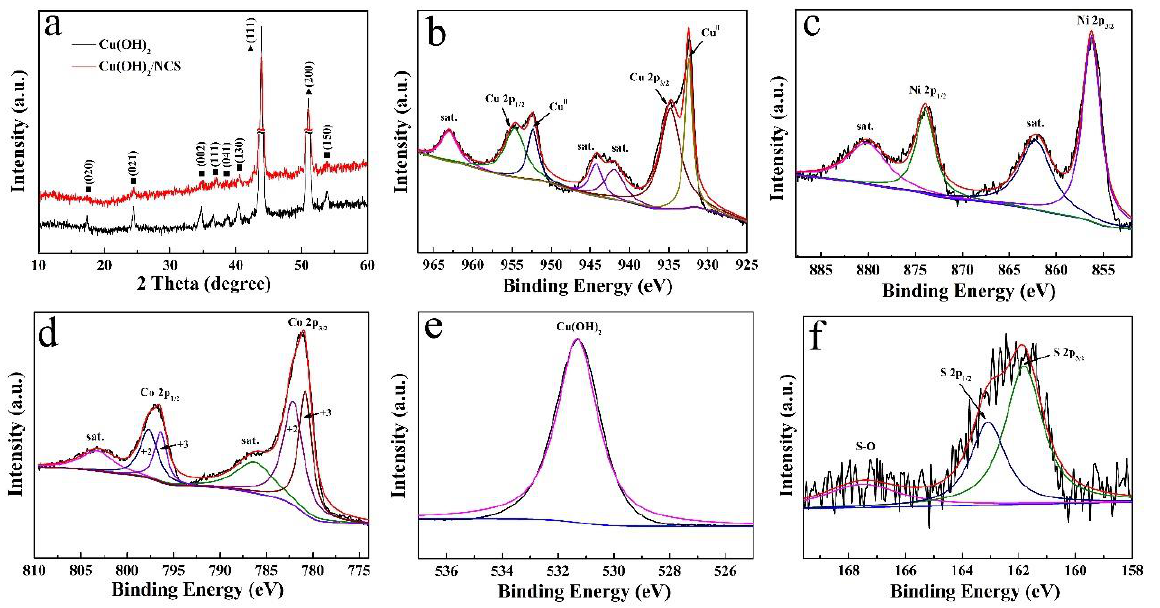
Figure 2. XRD patterns of Cu(OH) 2 and Cu(OH) 2 /NCS ( a ). XPS spectra of Cu 2p ( b ), Ni 2p ( c ), Co 2p ( d ), O 1s ( e ), and S 2p ( f